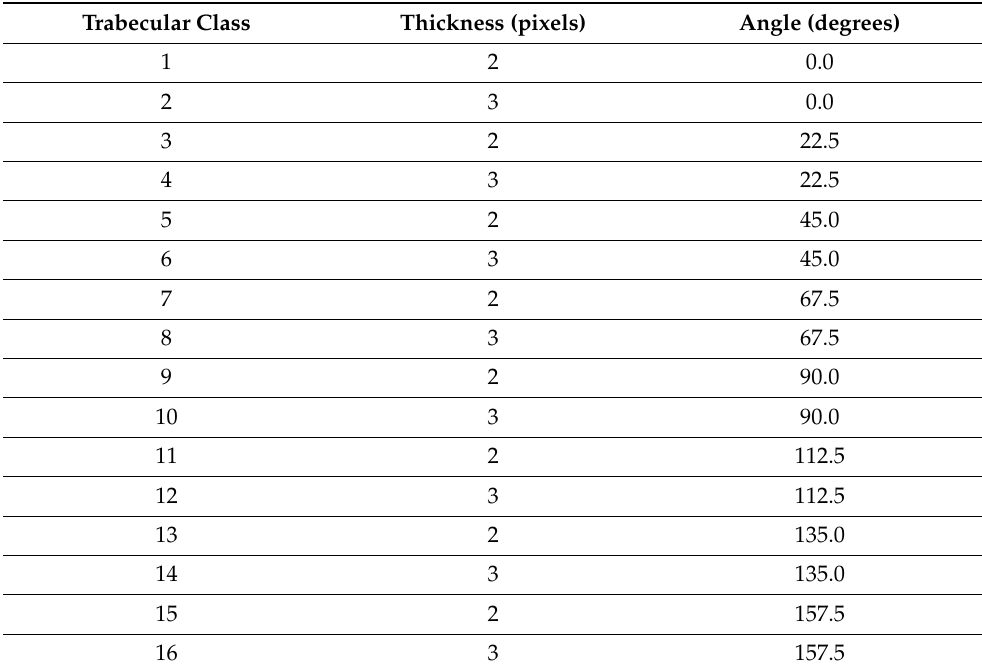
Table 1. The classes of metaphyseal trabeculae were defined by a unique combination of trabecular thickness (pixels) and orientation defined by angle